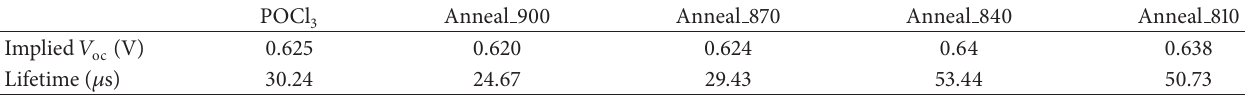
and lifetime. oc